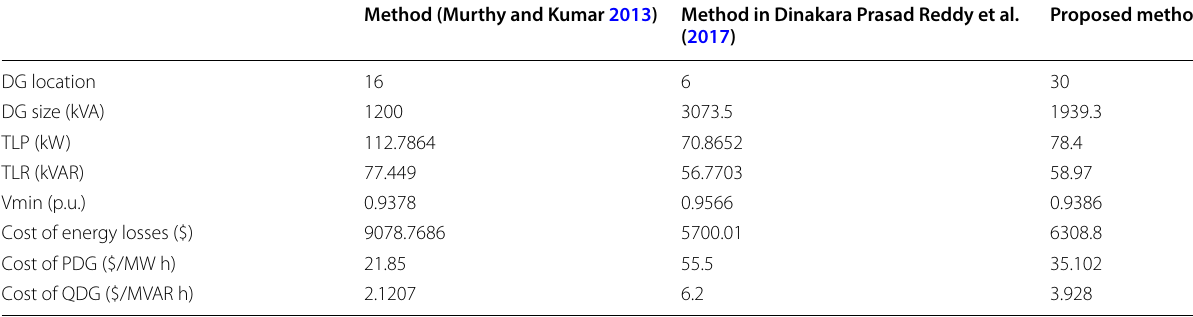
Table 6 Results for 33-bus system with DG at 0.9